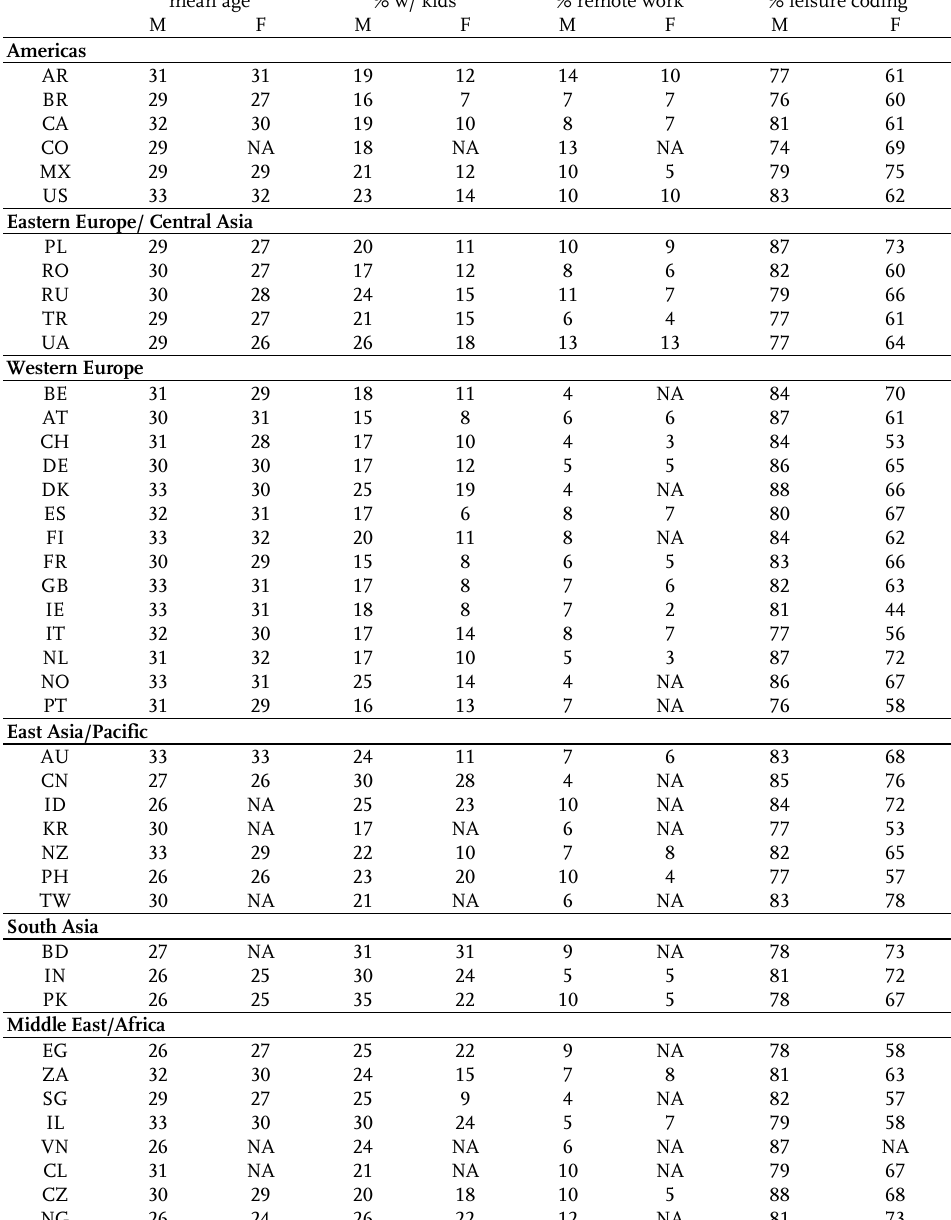
Table 1 : Characteristics of male and female software